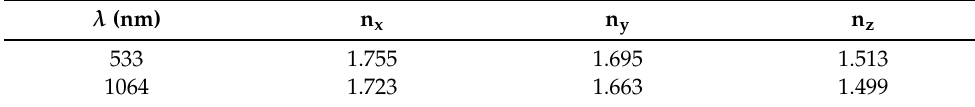
Figure 24. Transmission spectrum of GUHP crystal in the VIS-NIR spectral range [145]. Table 27. The refractive index of GUHP